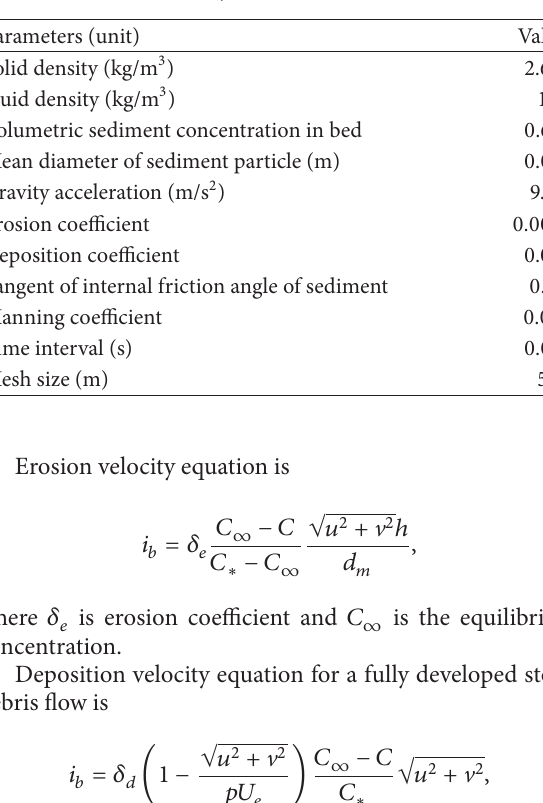
Table 2: Summary of values used in